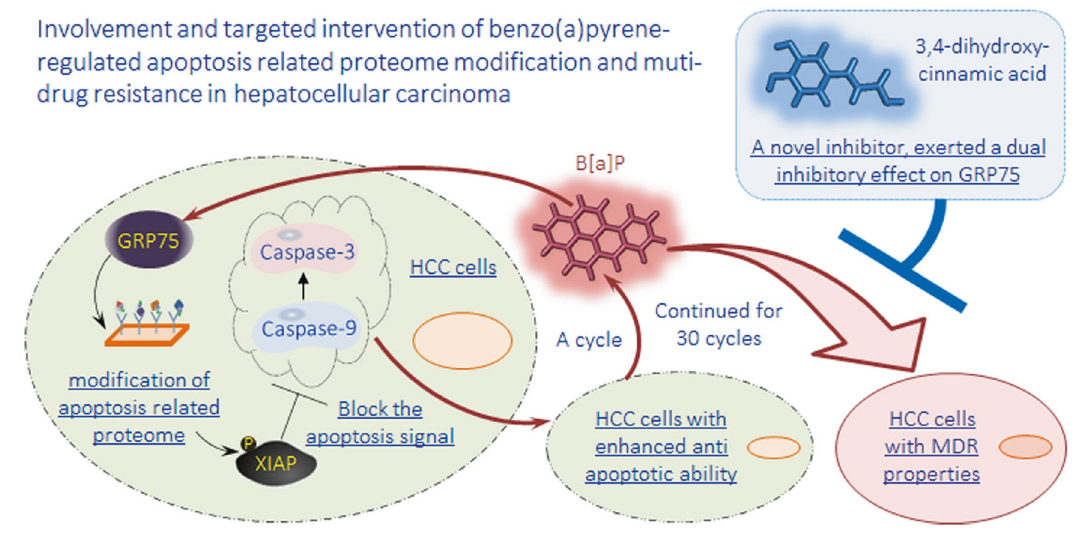
Fig. 8 A sketch map summarizing the